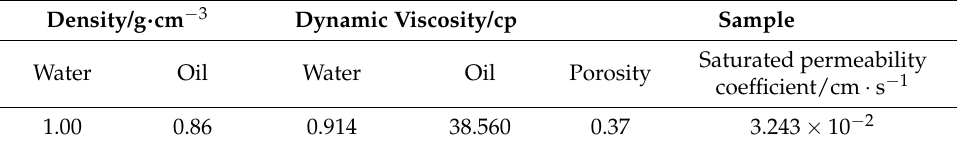
Table 1. Physical properties of rock sample and fluids (24 ◦